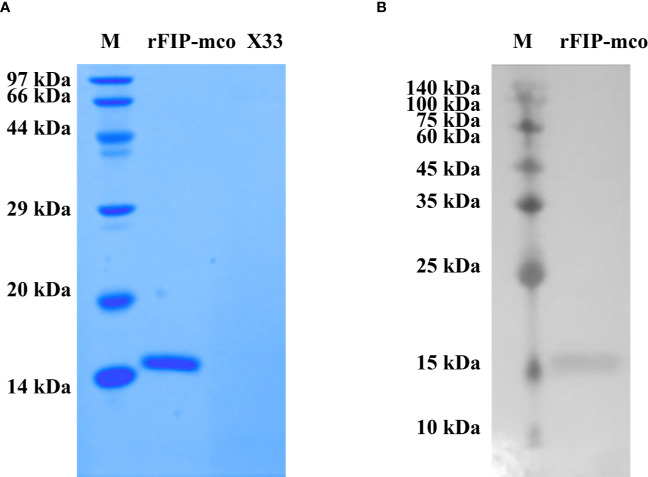
Expression and identification of rFIP-mco. (A) SDS-PAGE of rFIP-mco; supernatant of X33 strain broth as control (X33); Lane M - marker. (B) Western blot analysis of rFIP-mco; Lane M - marker.